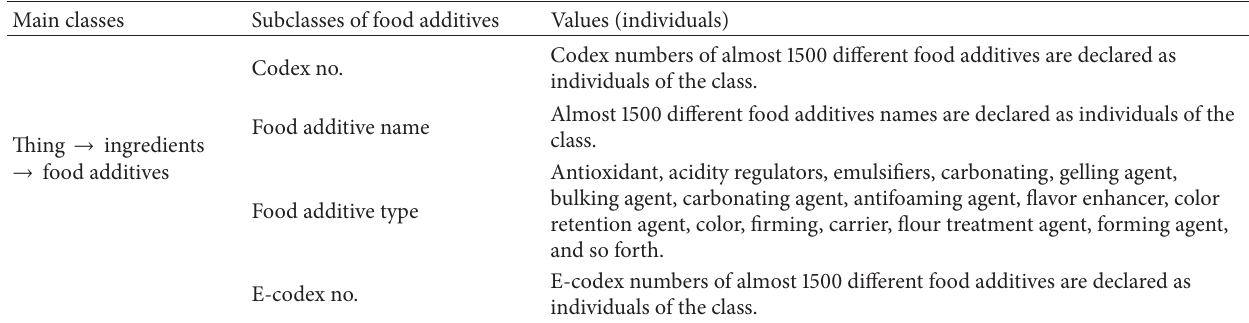
Table 7: The subclasses and individual entries of food additives class.